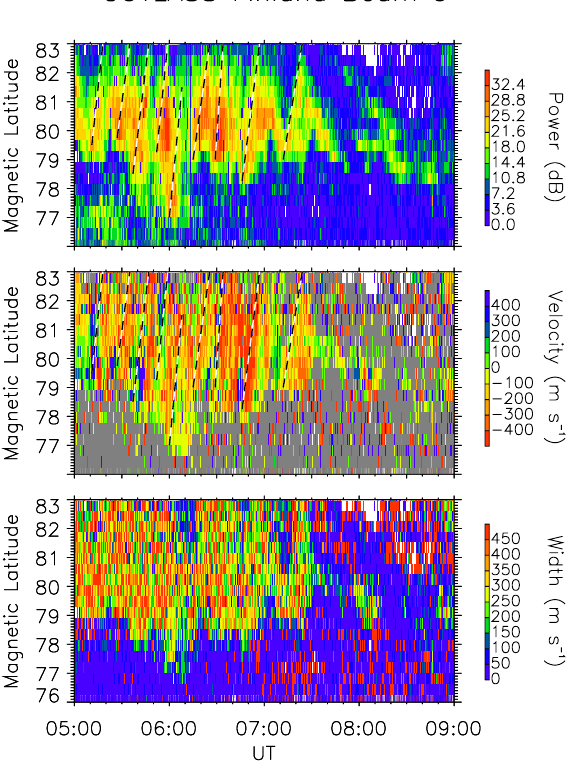
Fig. 7. Backscattered power, Doppler line-of-sight velocity and Doppler spectral width measurements from Beam 5 of the CUT- LASS Iceland SuperDARN radar. Data are presented as a function of magnetic latitude and universal time with each parameter colour- coded according to the scales shown on the right hand side. Line- of-sight velocity time-series from range gates 23 and 28 are overlaid at the appropriate